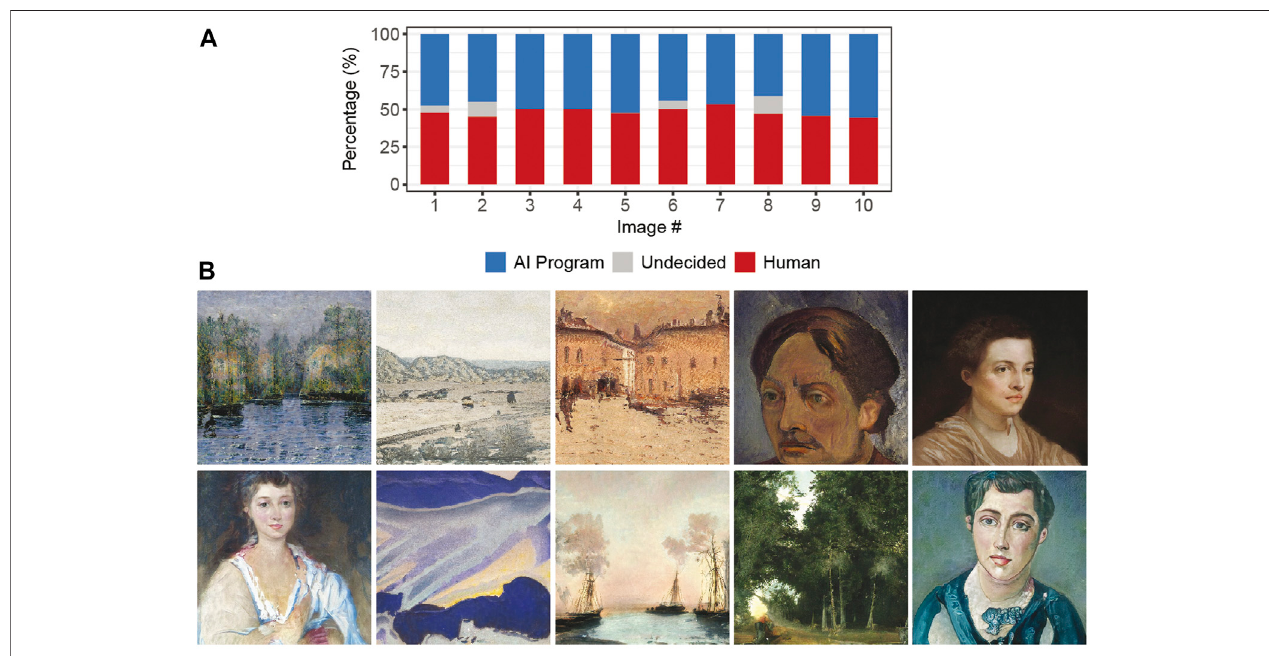
FIGURE1| Distributionofrespondents ’ judgmentsofthetop-10imagesselectedinourpreliminarystudyforStudies1and2 (A) .SelectedimagesusedinStudies 1 and 2 (B) .